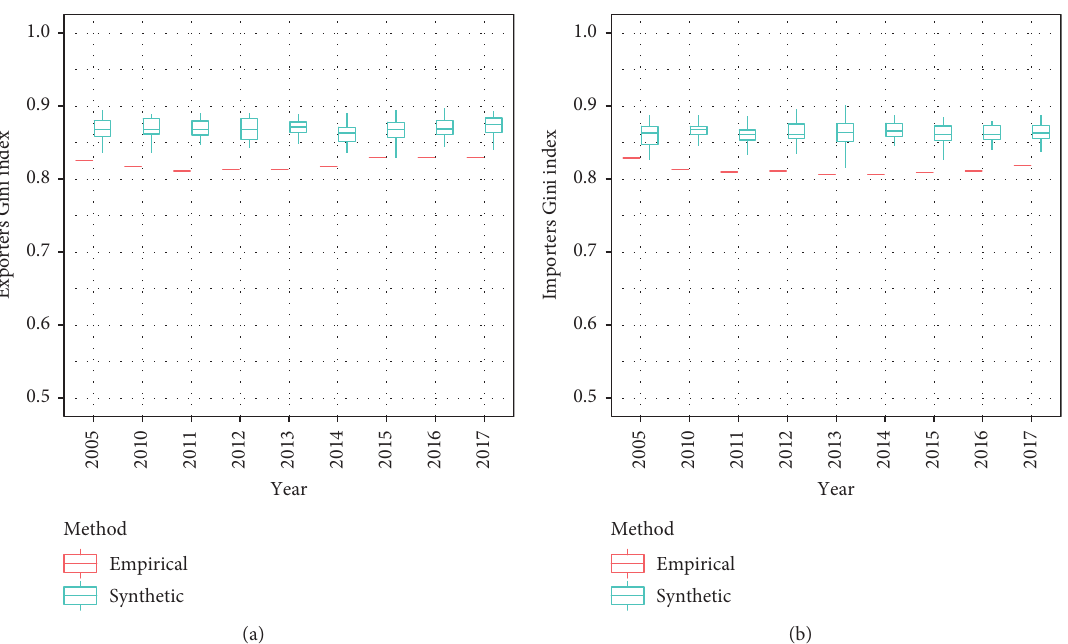
Figure 2: Gini indexes. Comparison of the Gini indexes for empirical networks and a set of 30 synthetic networks for each one: (a) exporter distributions and (b) importer distributions.